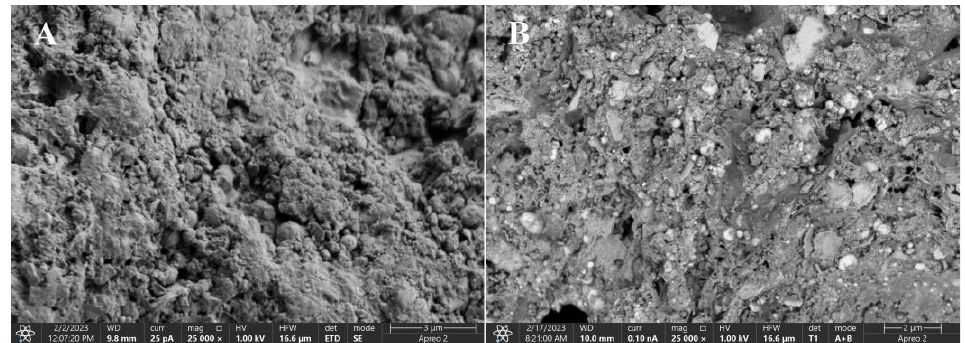
Figure 10. High-resolution scanning electron microscope images of SSB1 ( A ) and SSB6 ( B ) biochars.